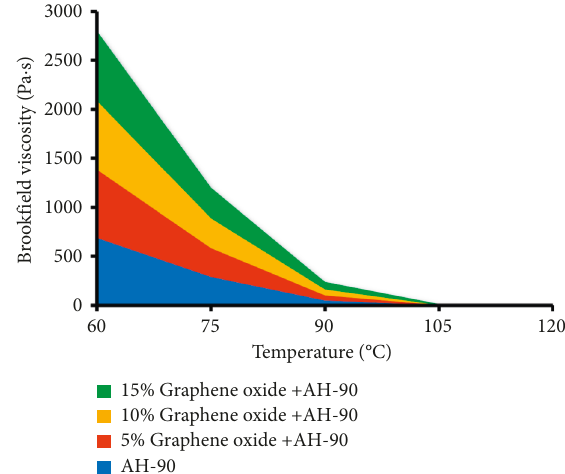
Figure 7: Brookfield viscosity of GO-modified asphalt.